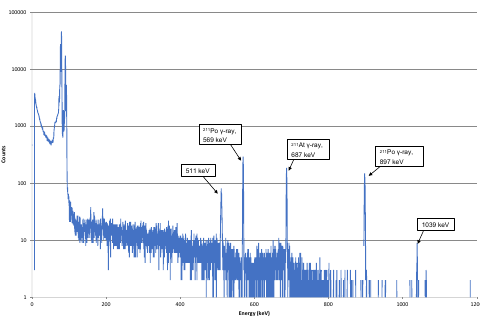
Figure 9. Typical HPGe Spectrum showing the characteristic γ - ray of 211 At at 687 keV, as well as peaks belonging to 211 Po and 66